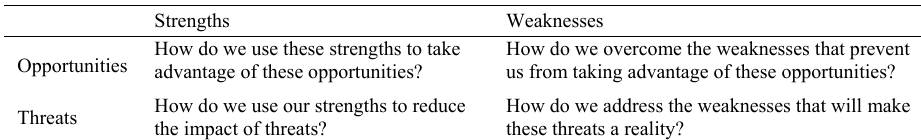
Table 1. SWOT analysis matrix